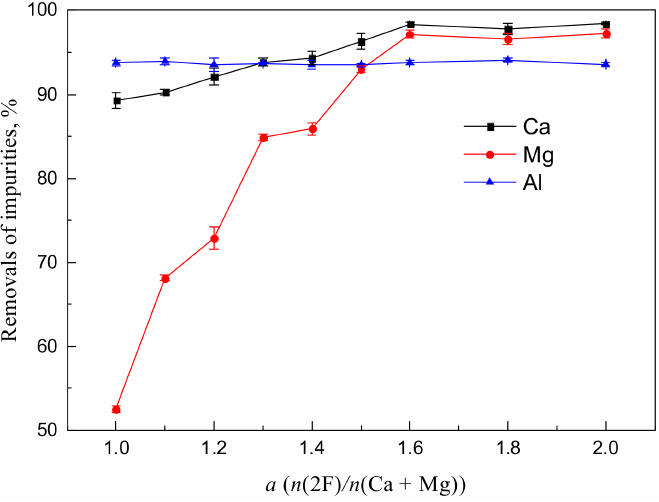
Figure 7. Effect of adding dosage on impurity